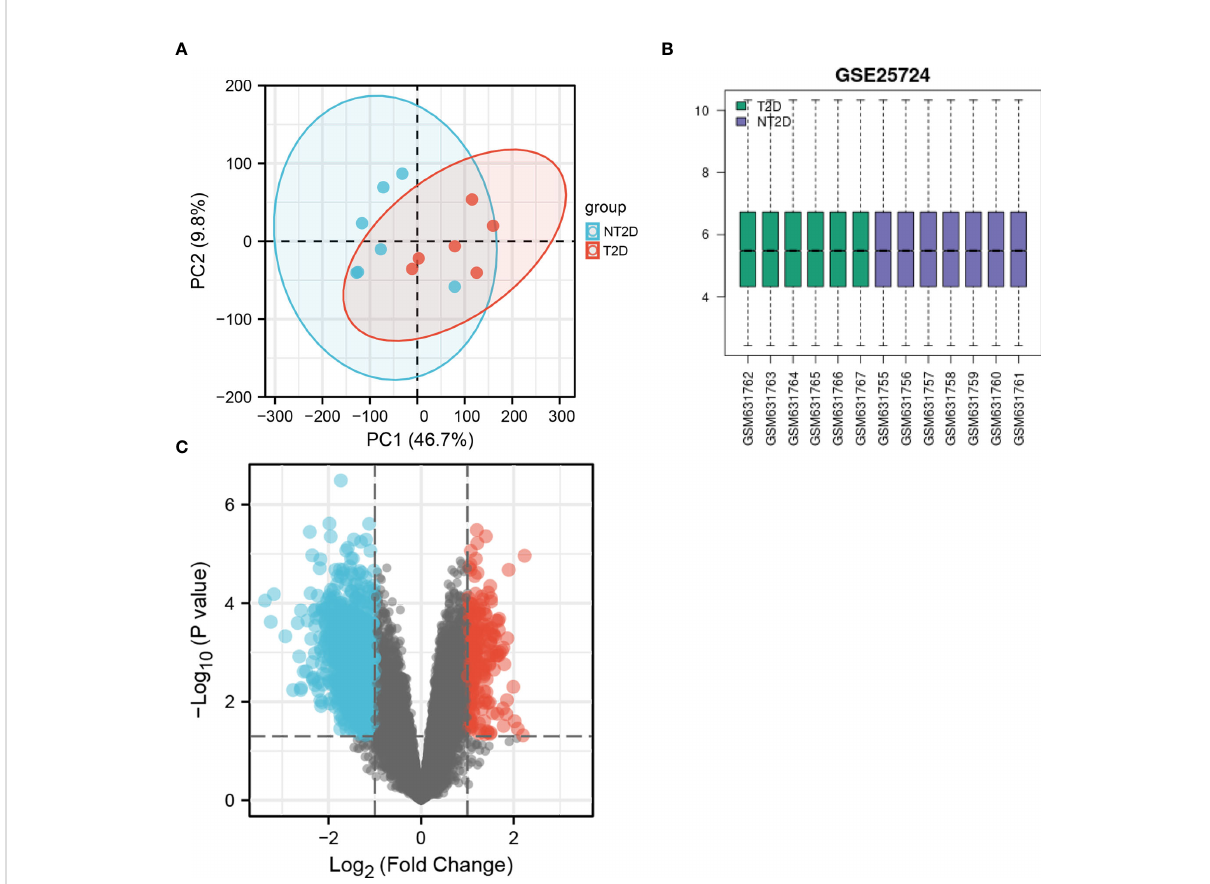
FIGURE 1 The PCA analysis and value distribution of the selected samples, and the volcano plot of the identi fi ed DE-mRNAs in GSE25724. (A) The visualization of principal component analysis for GSE25724. (B) The blue boxes represent NT2D samples and the pink boxes represent T2D samples. Black lines show the median of each data and its distribution represents the standardization degree of the data. (C) Volcano plot of the identi fi cation of DE-mRNAs, including 221 upregulated and 1,095 downregulated genes. Red, upregulation; green,